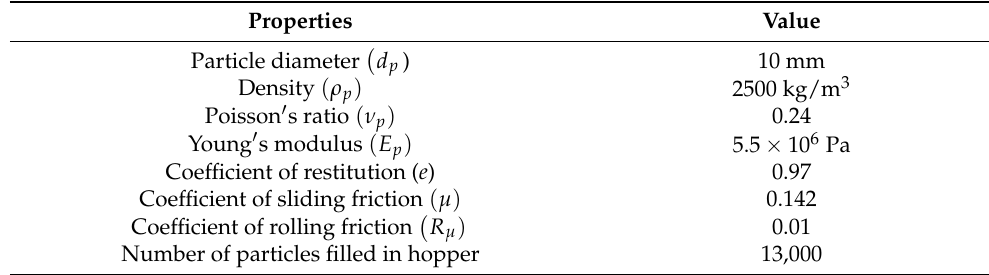
Table 3. Simulation parameter for angle of repose.